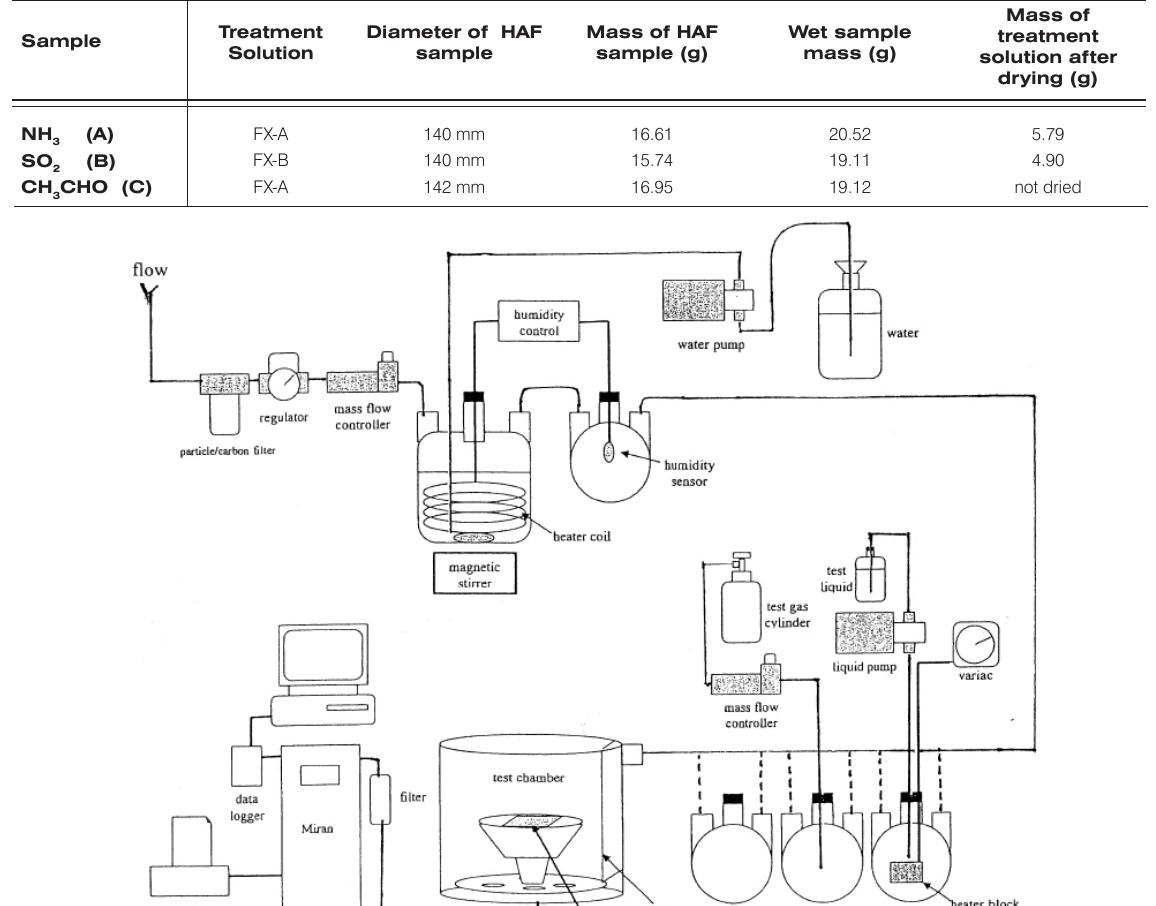
Table 1. FX treatment of HAF